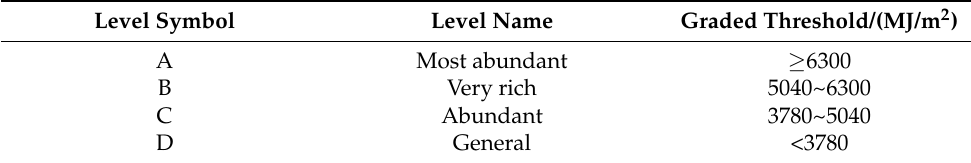
Figure 7. Spatial distribution of total horizontal solar radiation and annual sunshine hours in Shanxi province. Table 3. Level of total horizontal solar